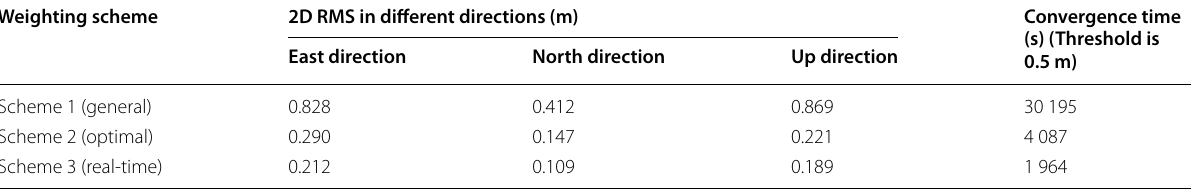
Table 3 Statistical results of PPP positioning errors and convergence time based on the static test data Weighting scheme 2D RMS in different directions (m)